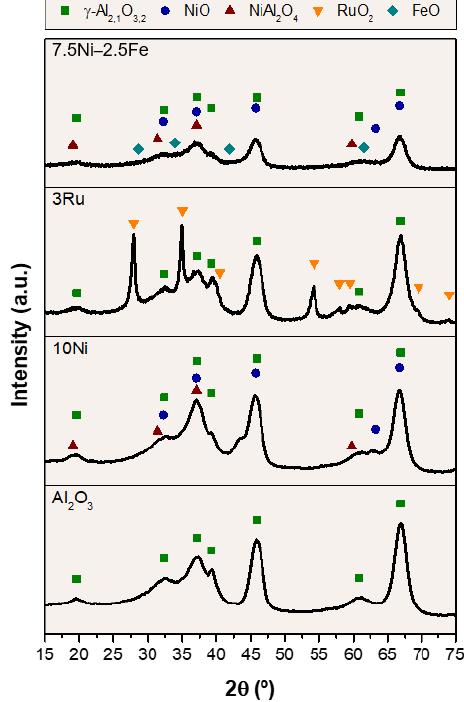
Figure 1. X-ray diffraction patterns of the catalysts and identification of the crystalline phases.